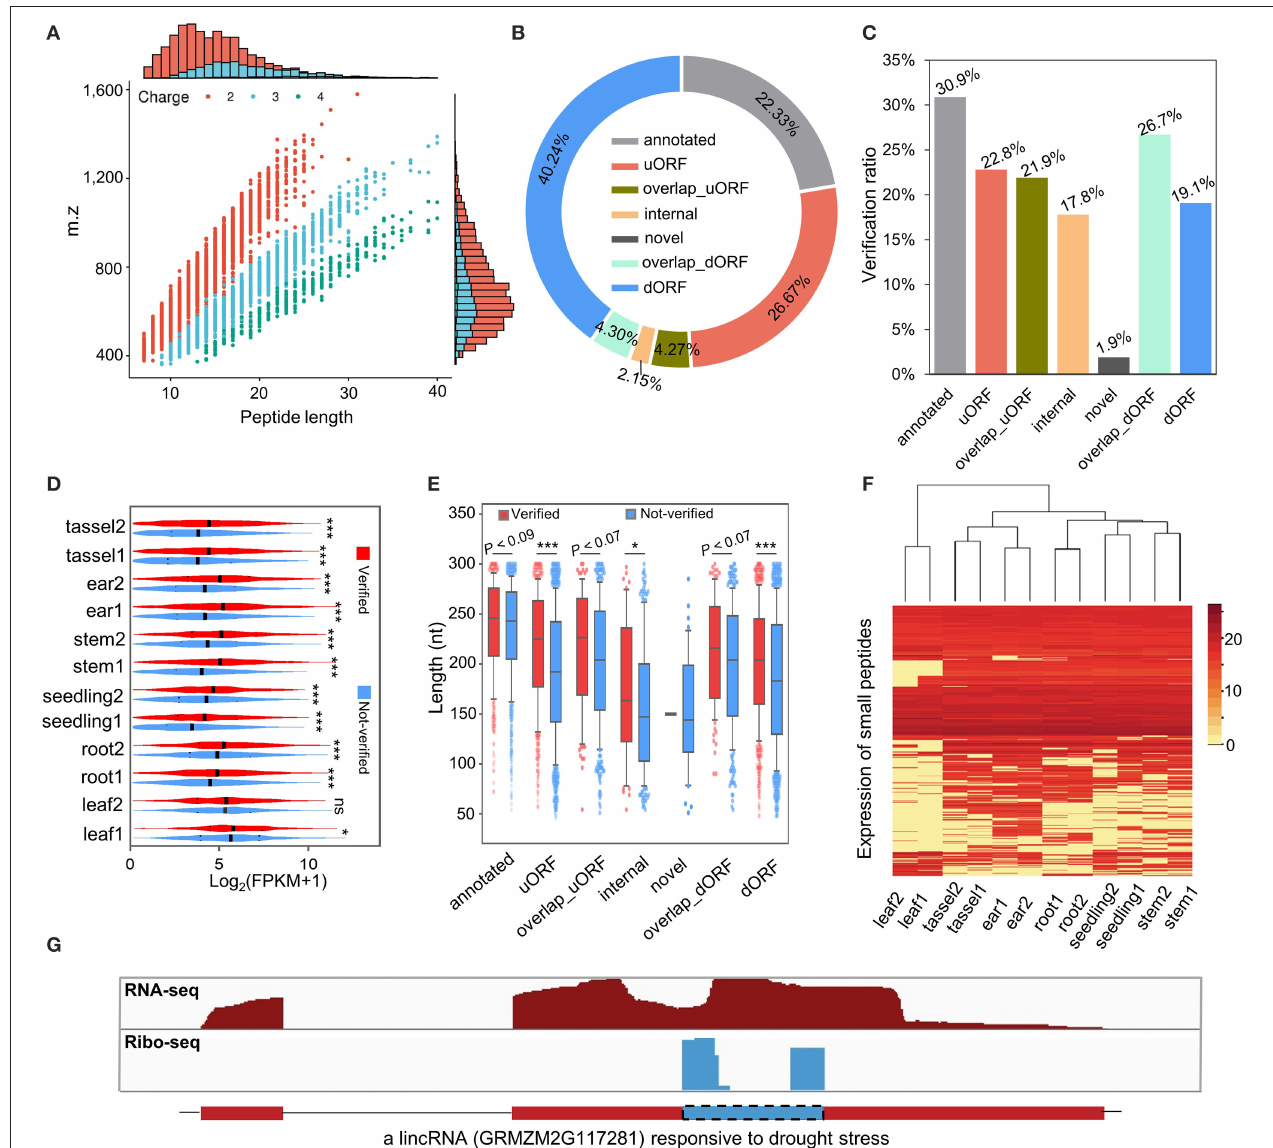
FIGURE 3 | Genome-wide classification and characterization of sPeptides in maize. (A) Mass spectrometry (MS) signals discriminate sPeptides and canonical proteins. (B) The proportion of different types of sPeptides in maize. (C) The validation rate of different kinds of sORFs was detected in this study. (D) Comparison of expression abundance between sPeptides and unverified sORFs. *, ** and *** indicate P -values of less than 0.05, 0.01 and 0.001, respectively (Mann–Whitney U -test). (E) Length differentiation between sPeptides and unverified sORFs in maize. *,** and *** indicate P -values of less than 0.05, 0.01 and 0.001, respectively (Mann–Whitney U -test). (F) Expression pattern of sPeptides in the 12 samples. (G) Structure of a sPeptide derived from a